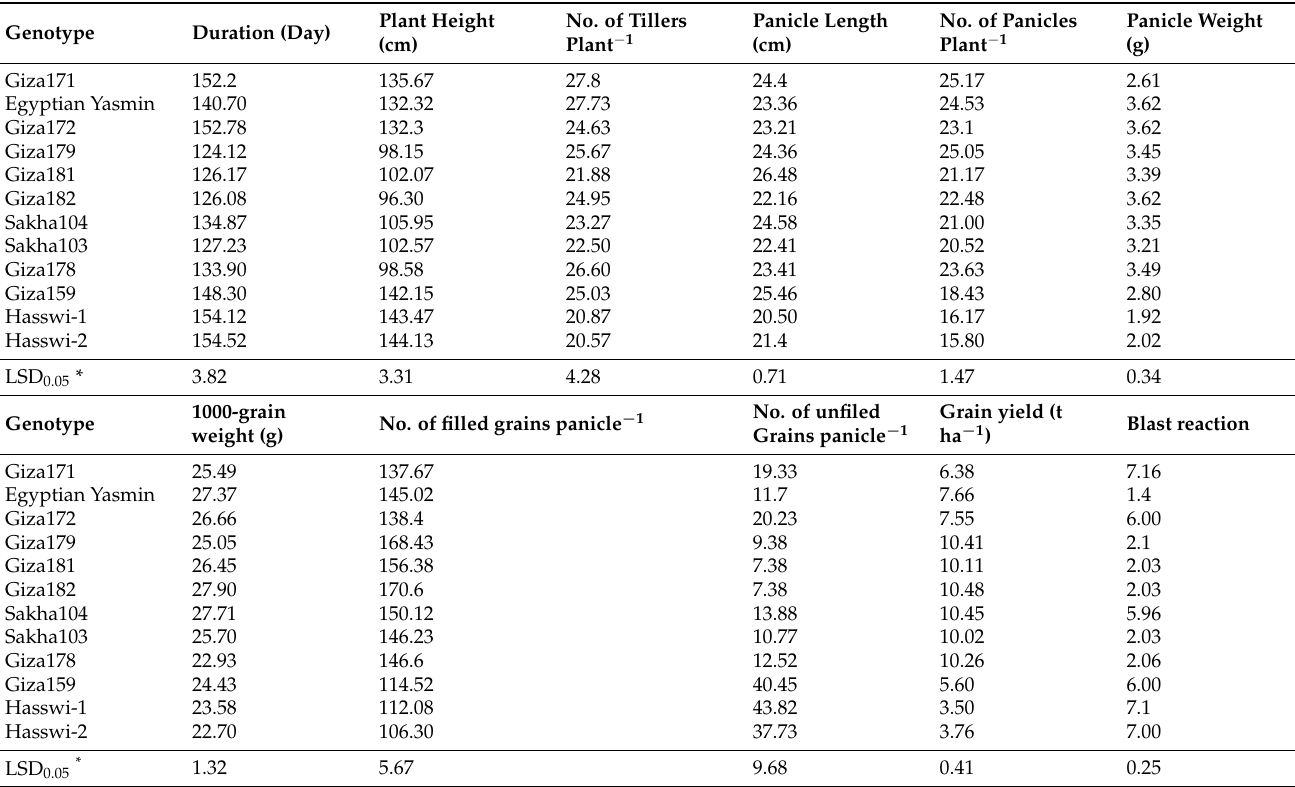
Table 4. Mean performances of agronomic and associated traits of 12 rice genotypes in 2019 and